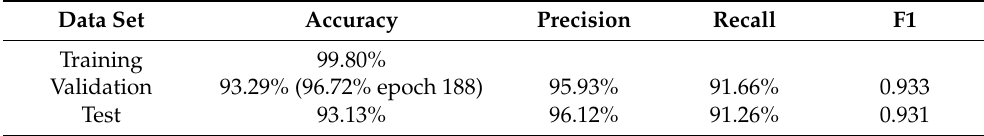
Table 6. MobileNetV2 classification Metrics, all layers trainable for 200 epochs.